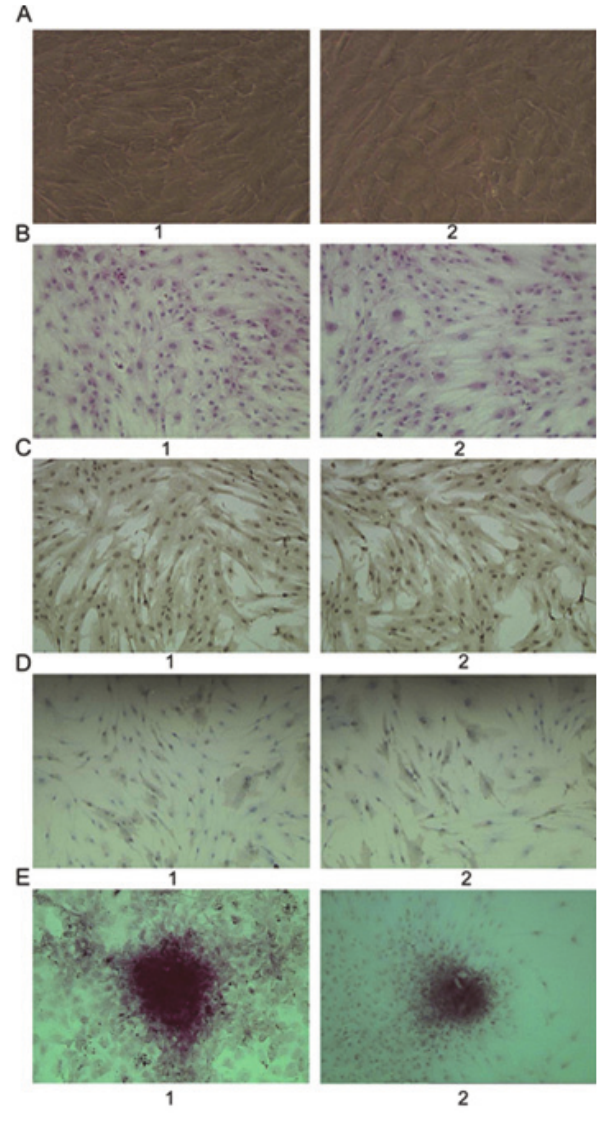
Fig. 1. Identification of osteoblasts (20×). A: morphology of osteoblasts; B: hematoxylin-eosin staining; C: expression of type I collagen; D: ALP staining; E: Alizarin Red S staining; 1: Non- diabetic group; 2: Diabetic